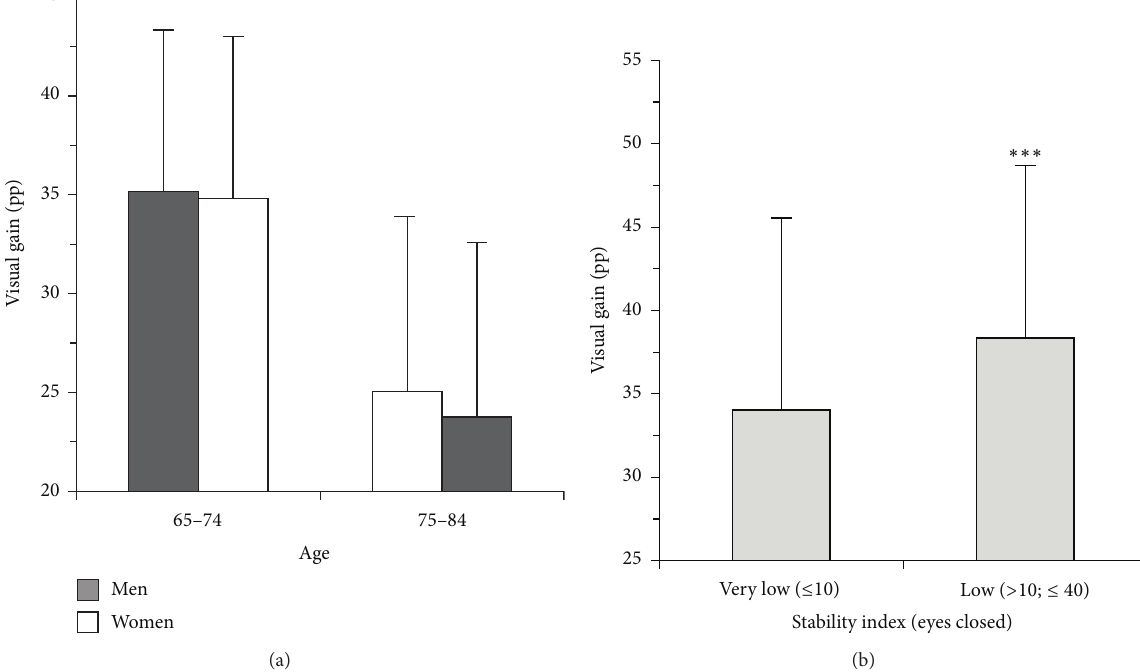
Figure 3: Single stance test (ST). The visual gain in supporting stability. (a) Visual gain according to sex and age: older women and older men showed a similar significant decrement of visual gain ( 𝑃 < 0.001 ) without gender differences. The greater decline of single stance stability in older women with respect to older men would be due to a more accentuated loss of proprioceptive control. (b) Visual gain according to different ranges of stability index in eyes closed; pp: Percentage points; ∗∗∗ 𝑃 < 0.005 .